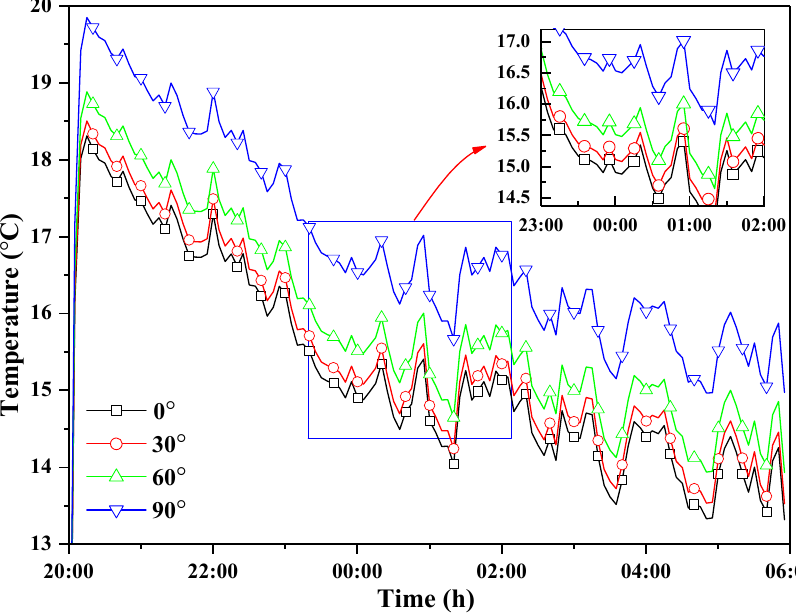
Figure 21. Time-dependent variation of the component surface temperature with different tilted angles.